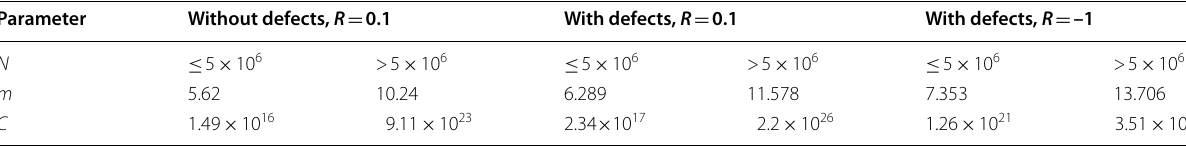
Table 2 Parameters employed in fitted S–N curve by smooth specimens of A357-T6 Parameter Without defects, R =